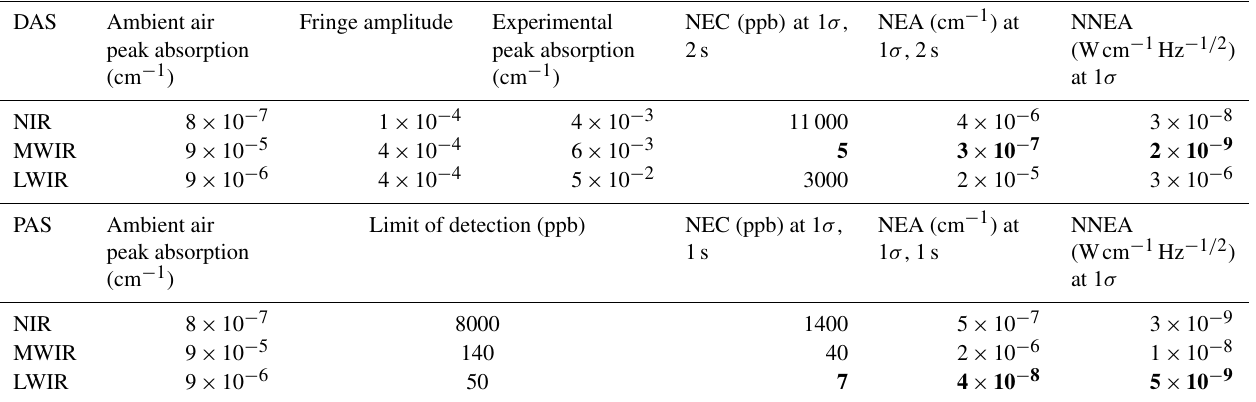
Table 6. Sensitivity comparison of DAS and PAS based on the data of the Allan–Werle plots. Characteristic metrics are given by the noise (NEC, NEA, NNEA), and the lowest sensitivities of each method are highlighted (bold values). Fringe amplitude Experimental DAS Ambient air peak peak absorption (cm − 1 )